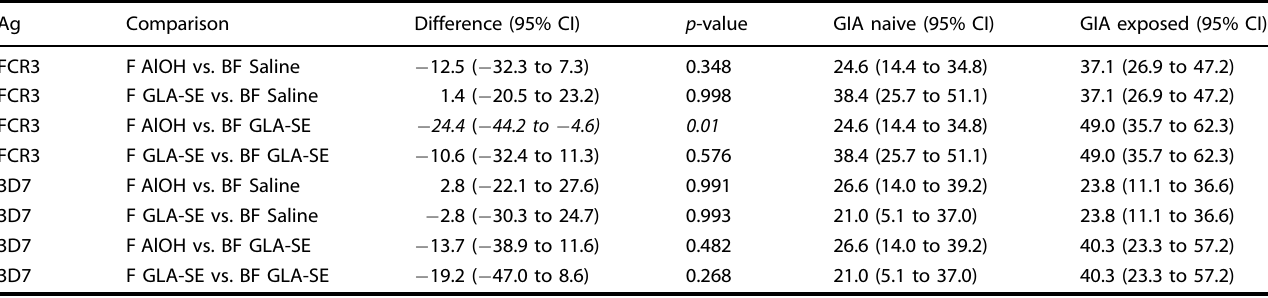
Table 2. Comparison of Week 30 GIA levels in malaria-naive and malaria-exposed adults. Ag